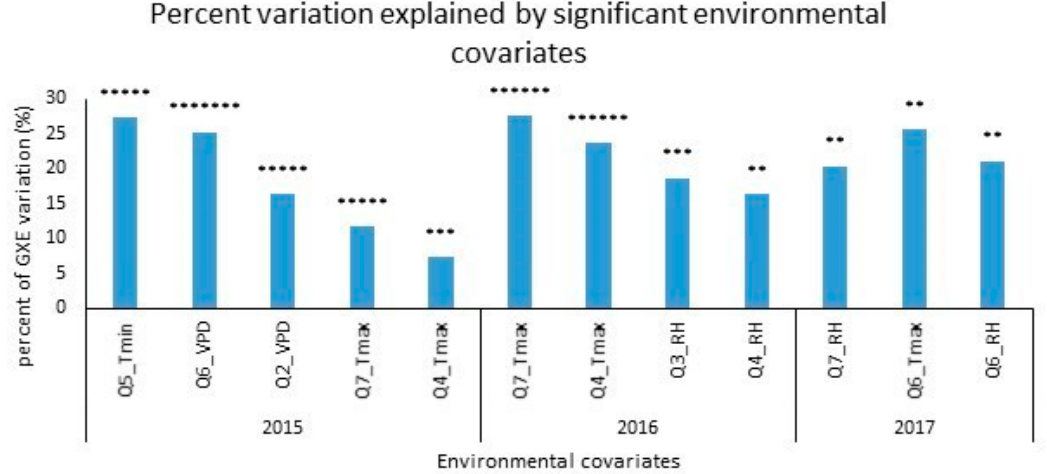
Figure 6. Percent variation of genotype × environment interaction explained by the most significant environmental factors estimated fortnightly during different growth stages of the crop. *—represents the level of significant ranged from 0.002 to 2.58 × 10 − 9 , Q1 to Q3—vegetative phase, Q4 to Q6—reproductive or flowering phase & Q7—early grain-filling phase, Tmax —maximum temperature, Tmin—minimum temperature, RH —relative humidity (%) at Tmax , VPD —vapor pressure deficit